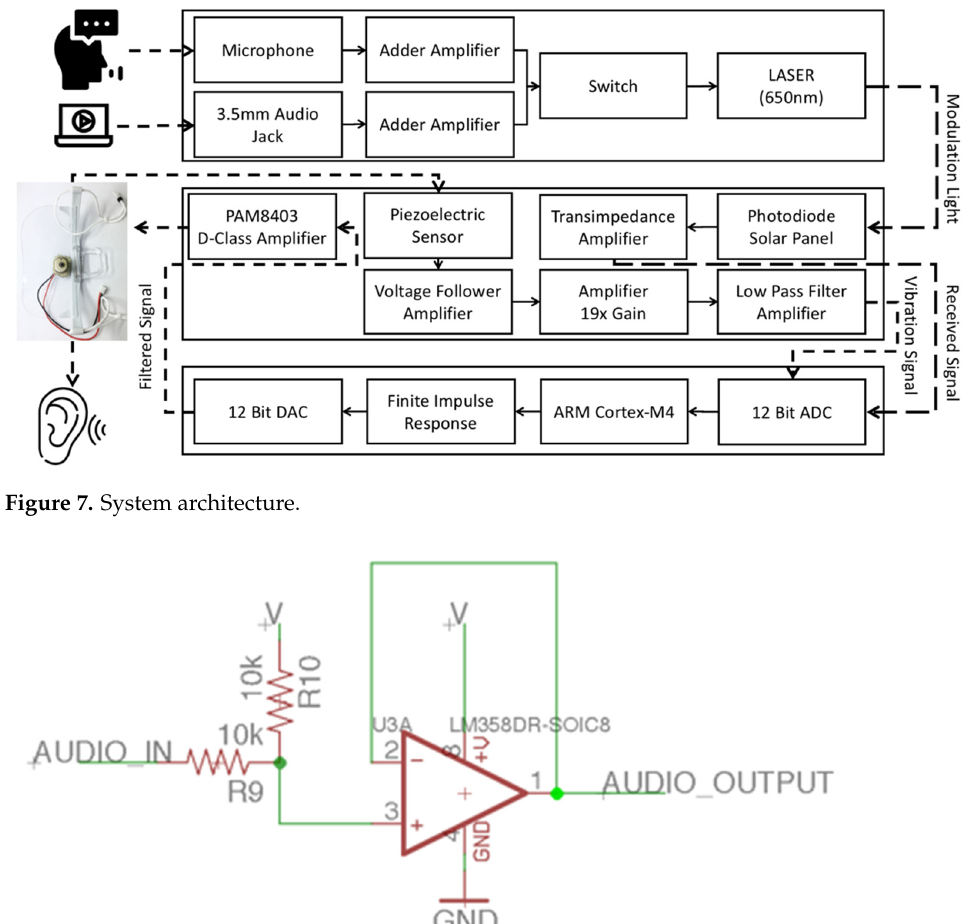
Figure 8. The audio signal input circuit of the laser audio transmission device.